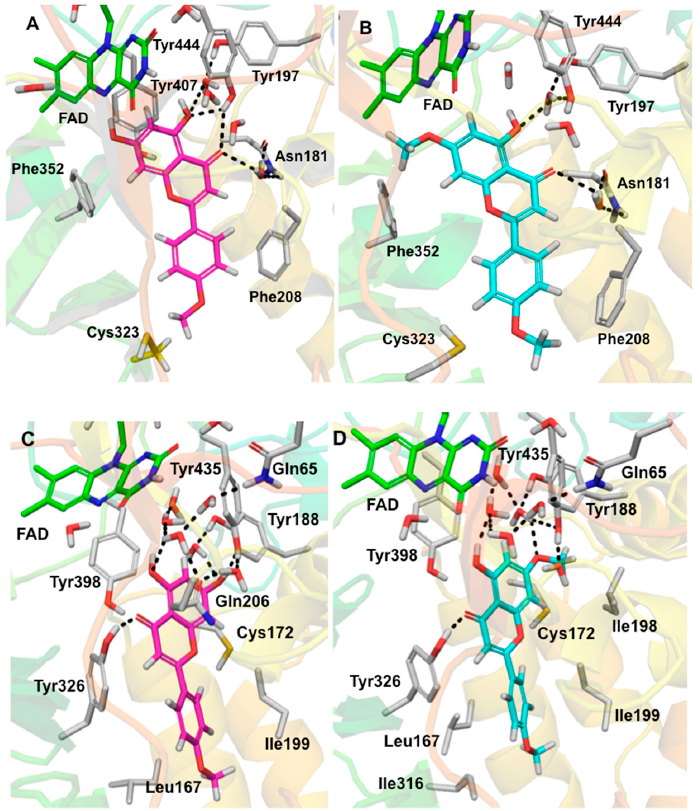
Table 3. Glide docking scores and binding free energies of acacetin and acacetin 7-methyl ether to MAO-A and MAO-B.